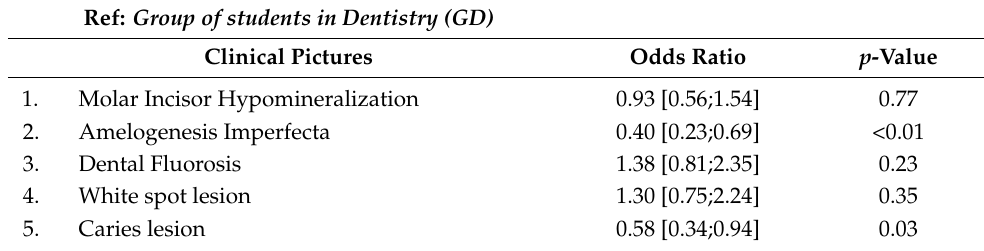
Table 3. Multivariate logistic regression analysis between GD and GDH on their recognition of clinical images. The correct answer was chosen as a